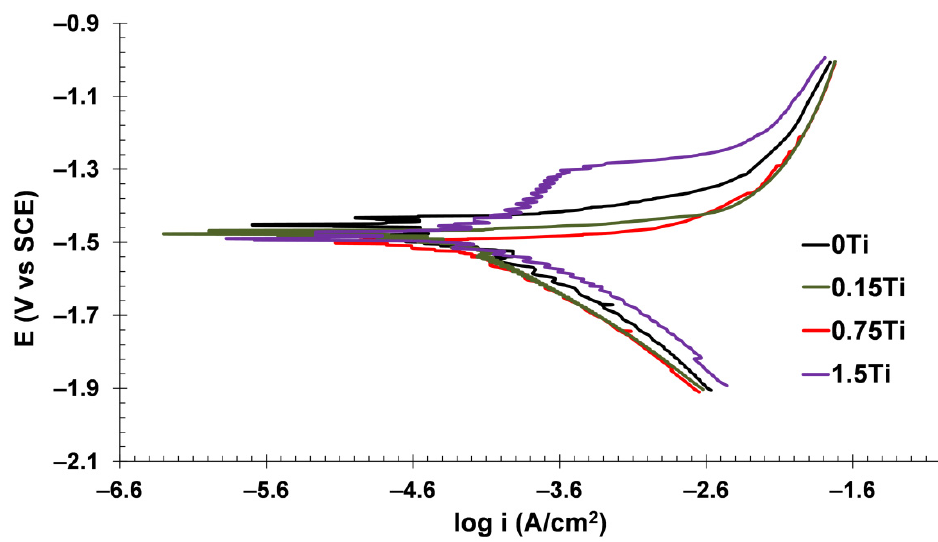
Figure 13. Polarization curves of the studied samples. Table 3. Electrochemical parameters driven from Tafel extrapolation of the polarization tests.